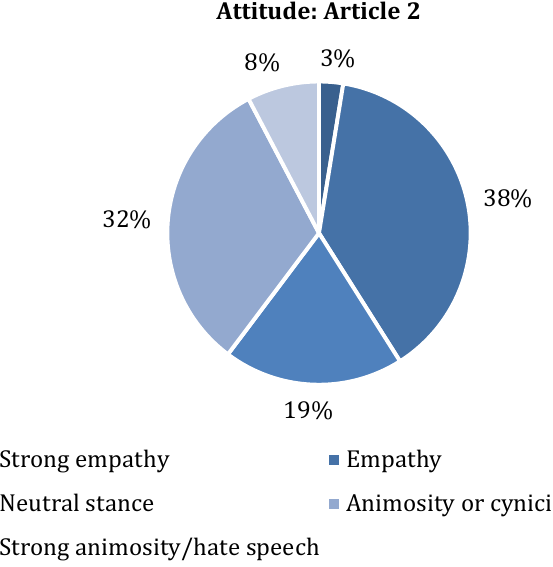
In the second article, of the 78 persons (58%) who did make reference to the victim, 2 (3%) showed high empathy, 30 (38%) empathy, 15 (19%) a neutral stance, 25 (32%) animosity or cynicism and, in six cases (8%) strong animosity/hate speech was present. This includes those who exhibited hate speech in their initial comments and those who agreed with such statements (Figure 4).